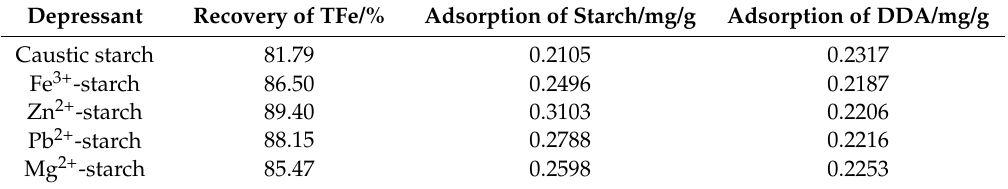
Table 3. Effect of MSC on the adsorption of flotation reagents (depressant 1200 g/t, DDA 625 g/t, pH 7.5). Depressant Recovery of TFe/% Adsorption of Starch/mg/g Adsorption of DDA/mg/g Caustic